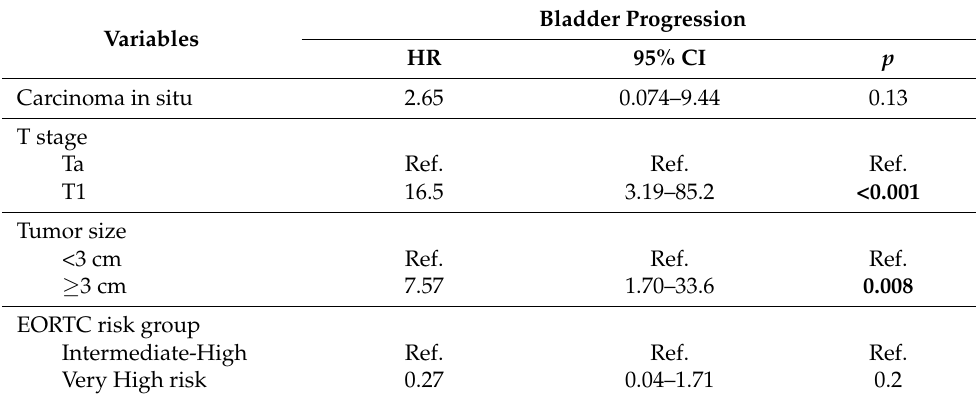
Figure 2. Progression-free survival after HIVEC in patients with and without CIS. Table 3. Multivariable results of Cox proportional Hazards Regression to predict bladder progression after HIVEC.